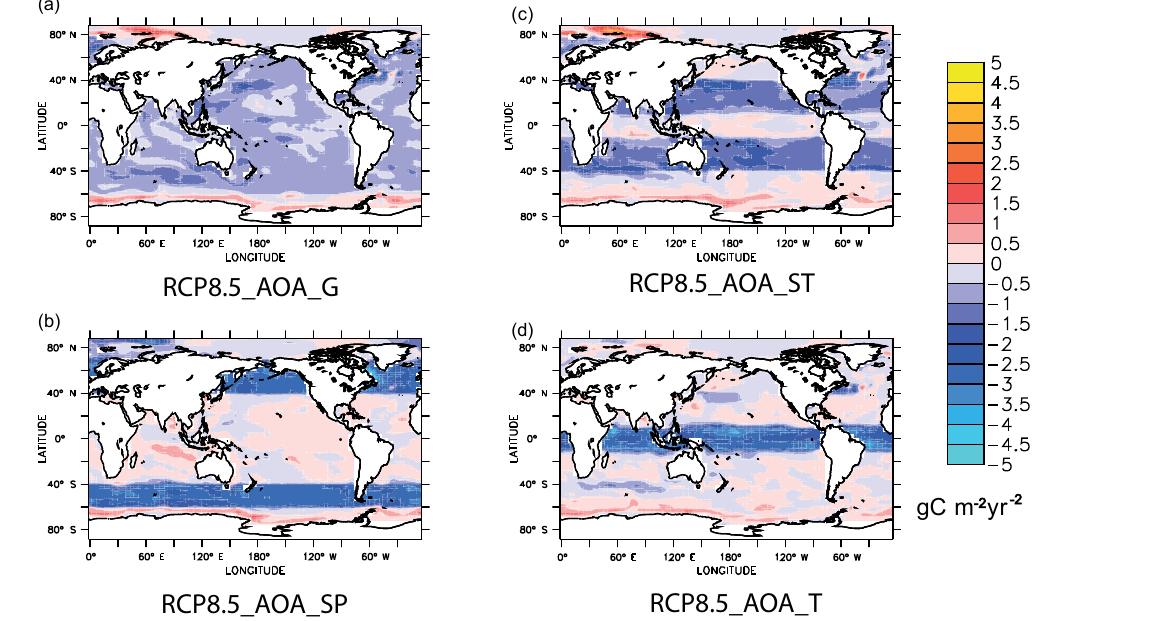
Figure 5. The spatial map of the changes in ocean carbon uptake in 2090 (mean; 2081–2100) associated with global and regional AOA under RCP8.5, relative to RCP8.5 with no AOA. Units are gCm − 2 yr − 1